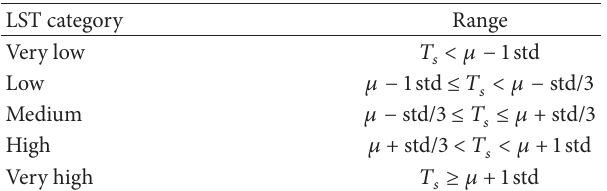
Table 1: Threshold values for LST classification. 𝜇 is the average value of LST; std is the standard deviation of